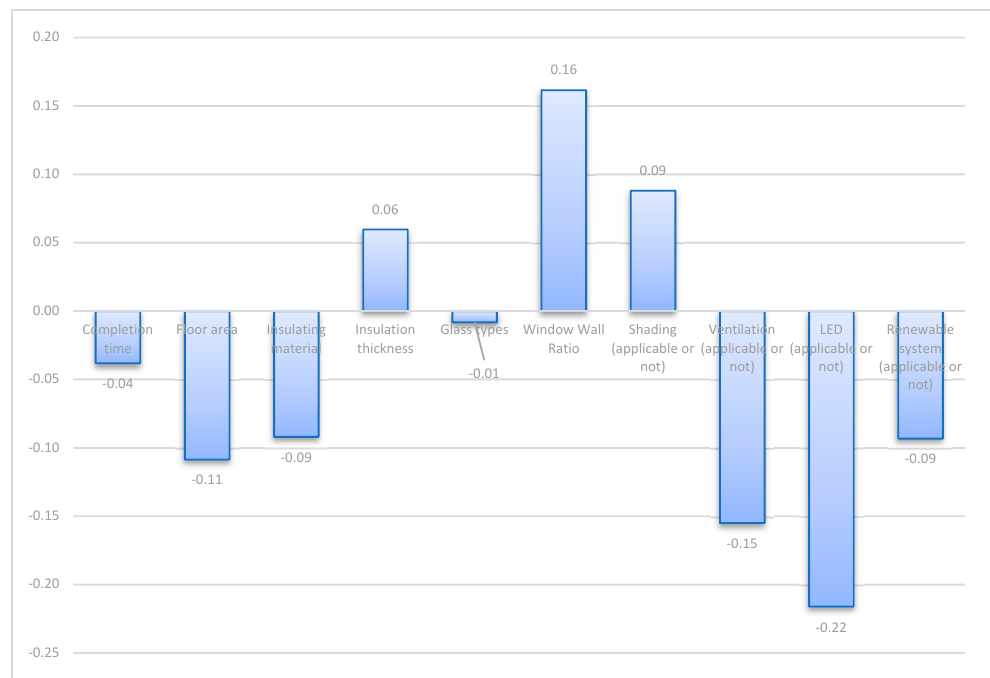
Figure 11. A visualization bar chart comparing correlation coefficients between the amount of energy usage and the green remodeling implementation strategy.